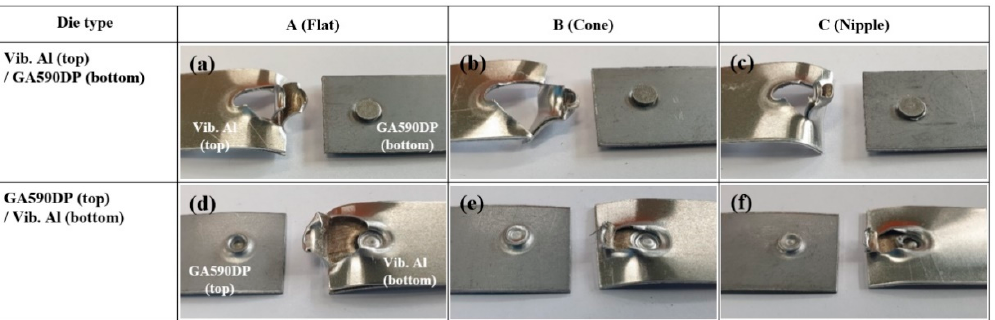
Figure 11. Failure modes of the self-piercing riveted joint formed between vibration-damping Al and GA590DP with respect to the die type and the panel configuration: ( a , d ) die type A , ( b , e ) die type B , and ( c , f ) die type C . The bottom side of the top panel is shown for ( d – f ).